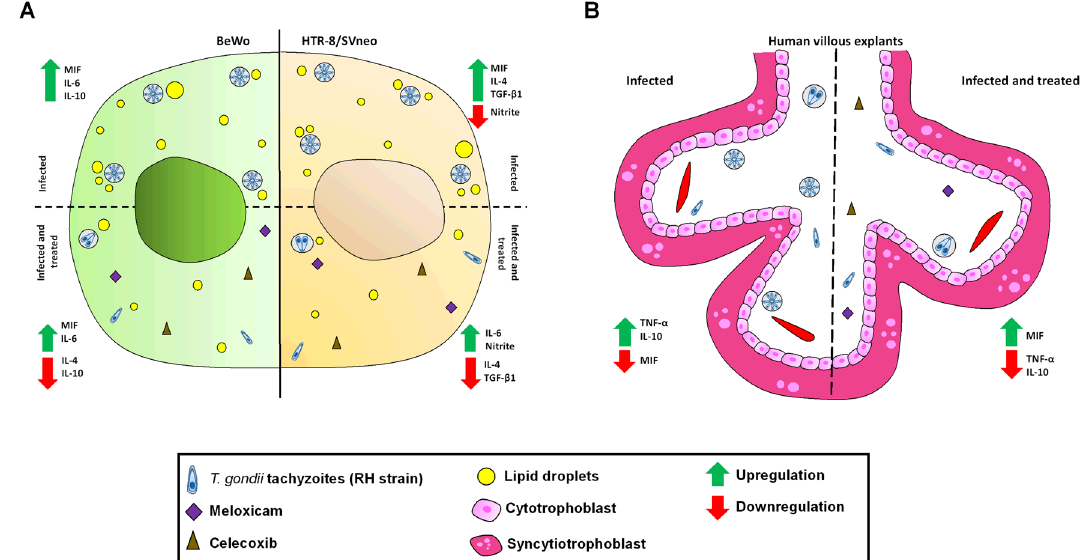
Figure 10. Proposed model of the role COX-2 inhibitors in human trophoblast cells and human villous explants. ( A ) BeWo cells (left panel) infected with T. gondii and treated with COX-2 inhibitors reduced parasite intracellular proliferation, upregulated pro-inflammatory cytokines (MIF and IL-6) e downmodulated anti- inflammatory cytokines (IL-4 and IL-10), besides decreasing the LDs production. In addition, HTR-8/SVneo cells (right panel) infected with T. gondii and treated with COX-2 inhibitors also reduced parasite intracellular proliferation, upregulated MIF and nitrite and downmodulated IL-4 and IL-10, besides also decreasing the LDs production. ( B ) Human villous explants infected with T. gondii and treated with COX-2 inhibitors reduced T. gondii intracellular proliferation, upregulated MIF and downmodulated TNF-α and